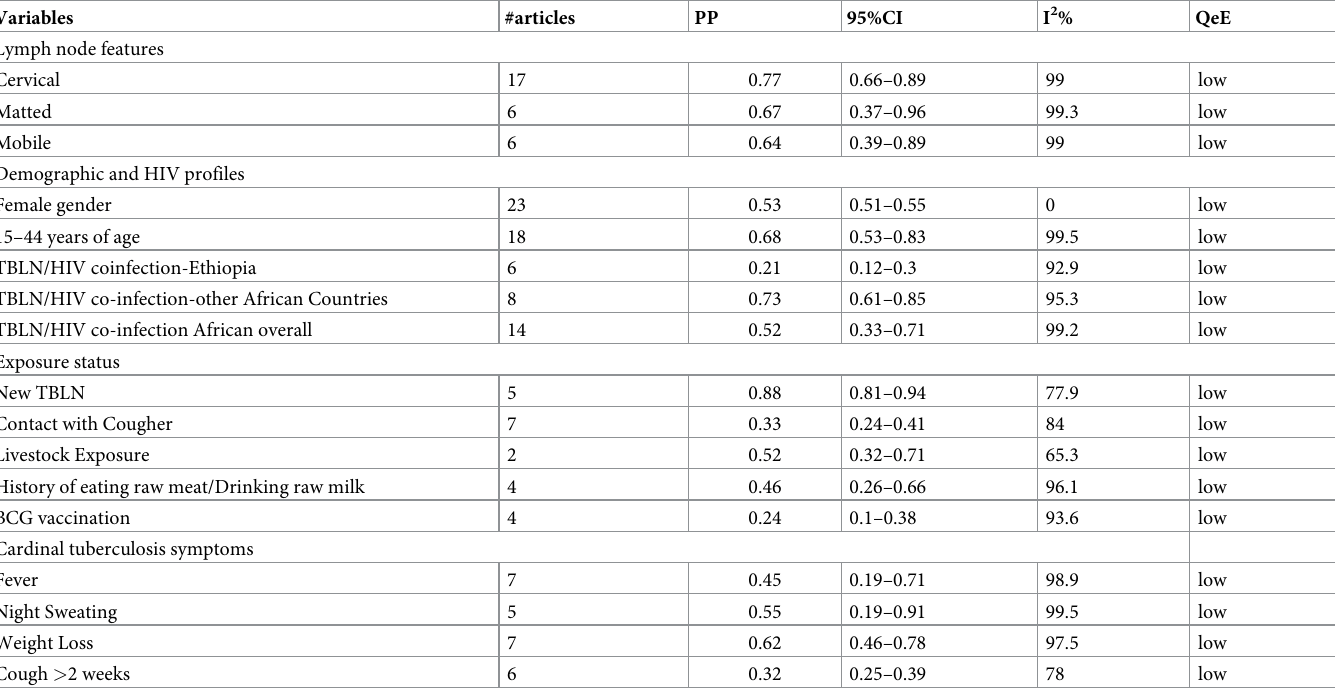
Table 3. A summary of pooled prevalence to key variables among tuberculous lymphadenitis patients, Africa,